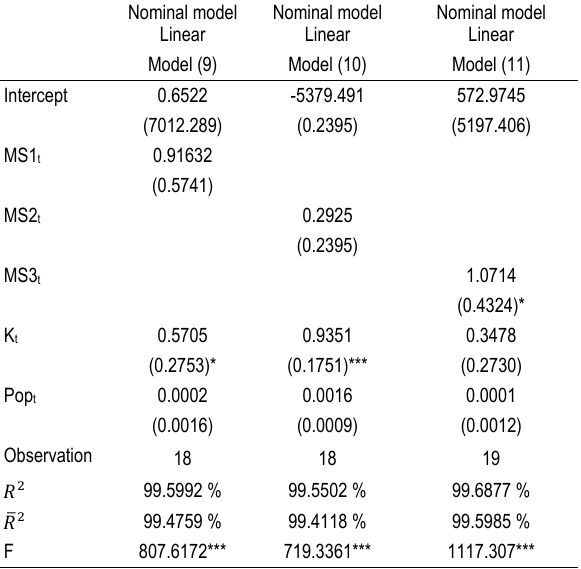
Table 4. The effect of money supply on output. Nominal GDP as the dependent variable